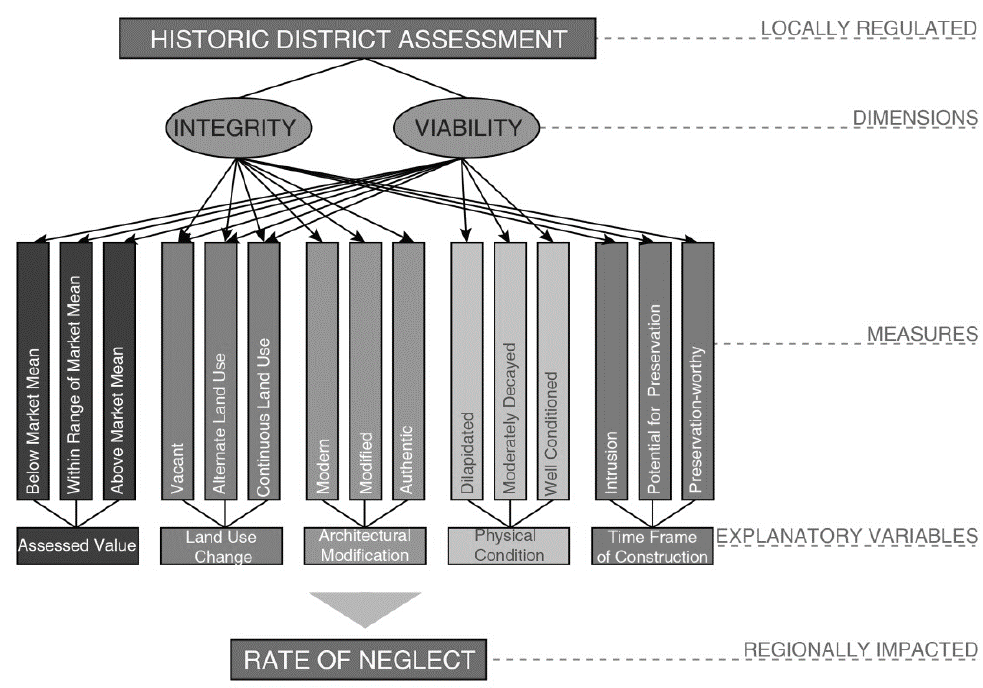
Figure 1. Newman’s Model of Measuring